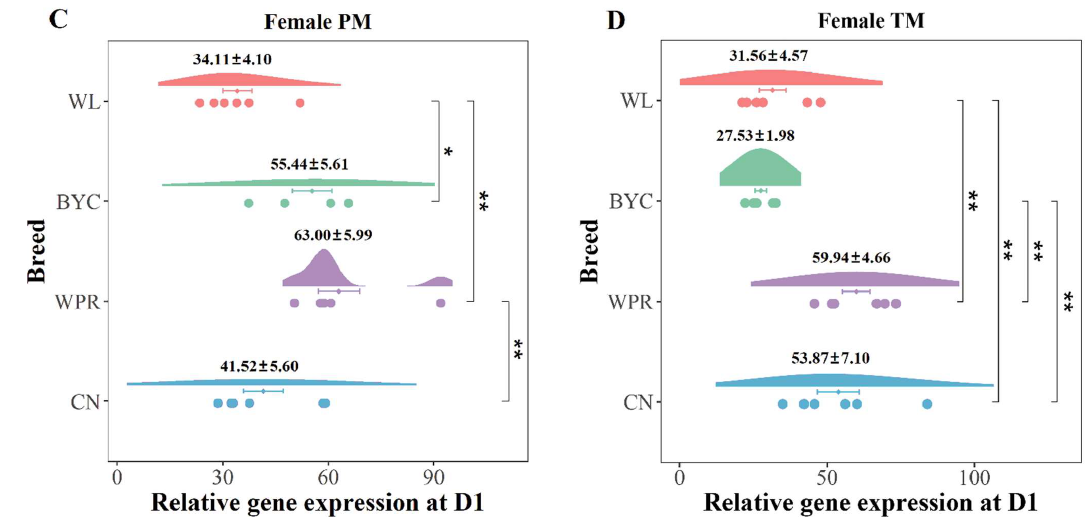
Figure 3. Gene expression of MYOD among the various chicken breeds at D1. ( A ) Gene expression differences of MYOD in the PMM among the four chicken breeds at D1. ( B ) Gene expression differ-